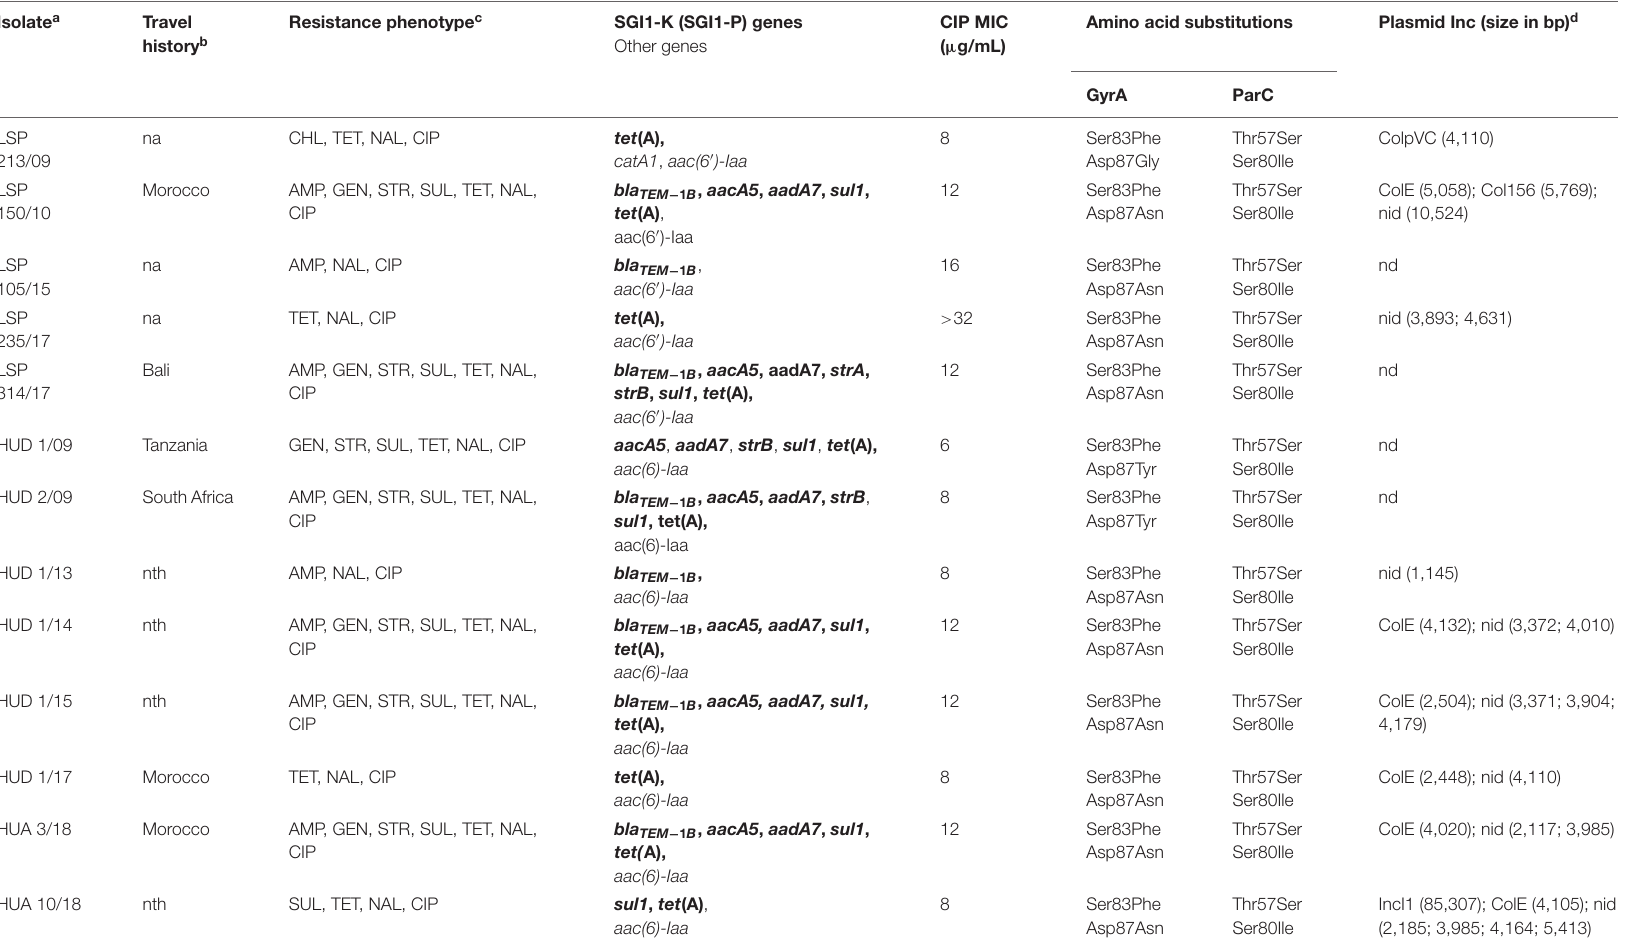
TABLE 1 | Origin and resistance properties of Salmonella enterica serovar Kentucky ST198 isolates from Spanish hospitals. Isolate